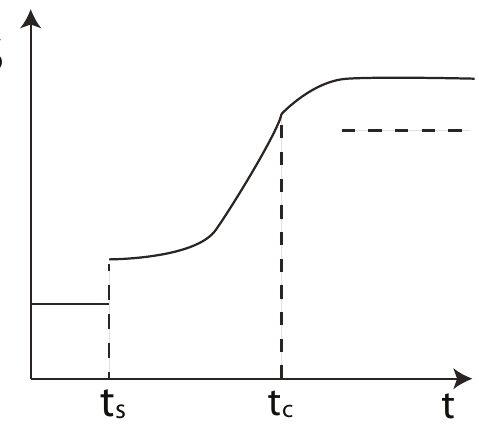
Figure 9 . The schematic picture of the entropy evolution in time. The black hole triggers the vacuum decay through instanton process at t s . The entropy increases according to eq. (3.14), and in addition due to the entropy of particles created during the vacuum tunneling. The bubble wall produced during the tunneling keeps expanding and generating more entropy, since more particles are created during the expanding phase. At t c the wall grows to the size of the old cosmic horizon and keeps pushing the horizon outward to its final size. Entropy is produced by both particle creation and the expansion of the cosmic horizon after t c . Finally the wall leaves the new horizon and the entropy remains constant. The horizontal dashed line shows the entropy counted in the first law of the black hole thermodynamics, which is always lower than the actual entropy.